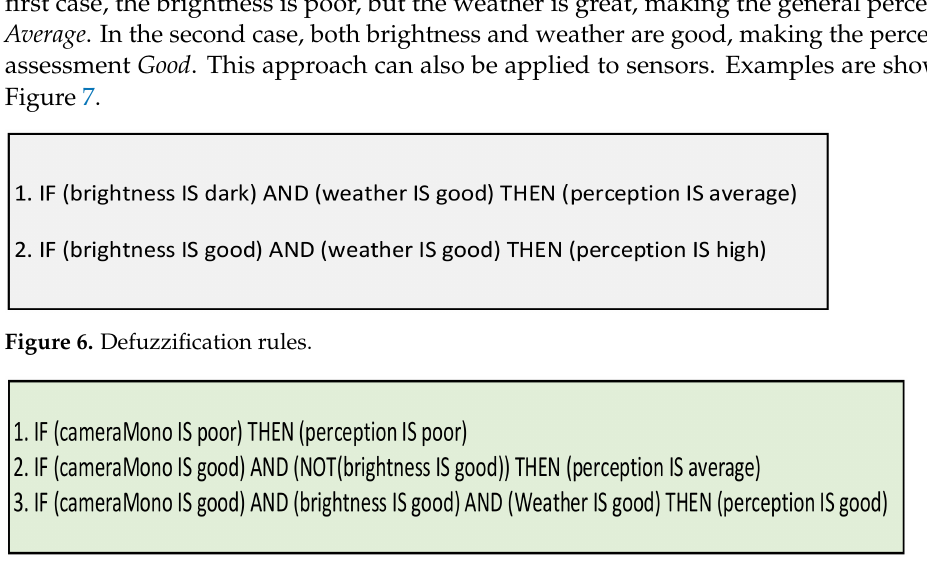
Figure 7. Defuzzification rules for